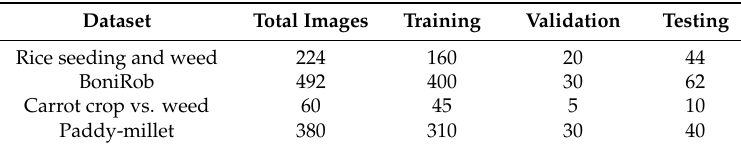
Table 1. Dataset distribution for training, validation, and